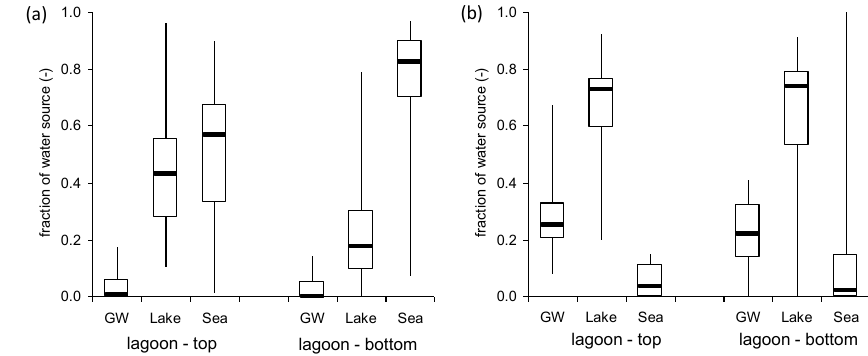
Figure 6. Fractions of different sources of the lagoon water for (a) dry and (b) wet season sampling campaign.